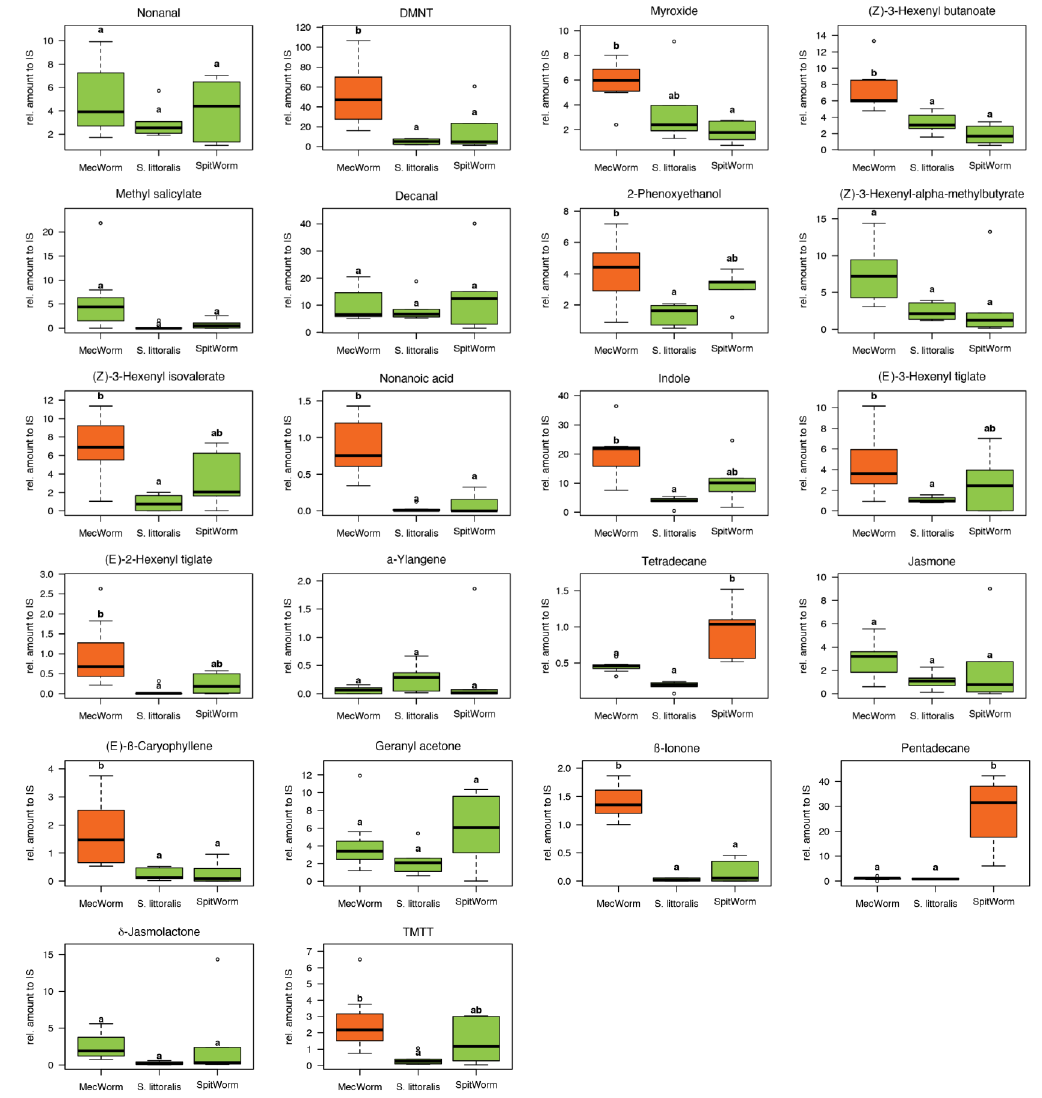
Figure 7. Comparison of relative amounts of headspace volatiles upon different treatments. Three different treatments on lima bean leaves ( S. littoralis larvae, n = 6; MecWorm, n = 7; SpitWorm, n = 6). One-way ANOVA; post hoc test: Tukey’s HSD; treatments with identical letters showed no significant difference; equal colors indicate no significant difference to SpitWorm treatment. A principal component analysis (PCA) of all treatments and relative amounts of all 38 compounds revealed significant differences between MecWorm treatment and SpitWorm and S. littoralis larval treatment, whereas confidence areas (95%) of SpitWorm and S. littoralis treatments overlap almost completely (Figure 8). The two principal components, PC1 and PC2, explain 55.2% of all observed variances.